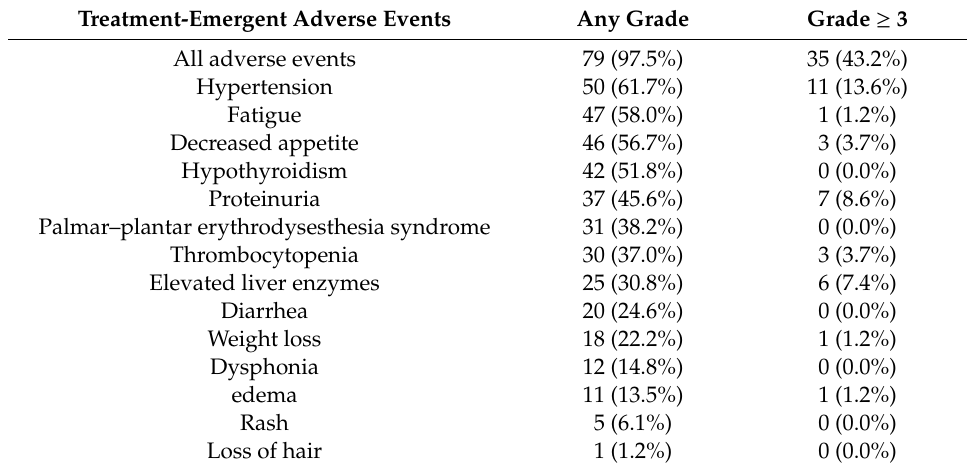
Table 2. Frequency of treatment-emergent adverse events.